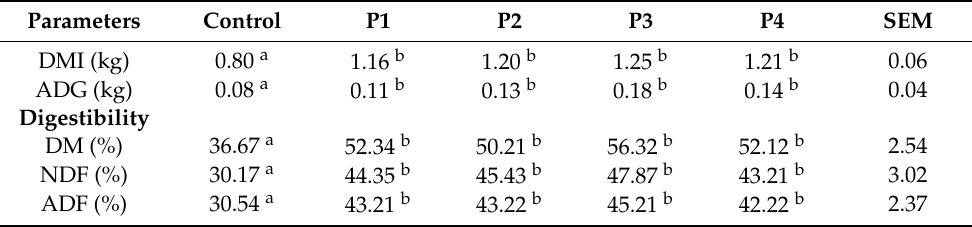
Table 7. The parameters of growth performance of goats fed probiotics in hot summer.